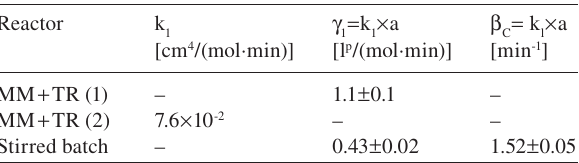
Figure 4 Parity plot in which all results of the simulation made by using different types of reactors are compared with the experi- mental results. Well stirred batch reactor ( (cid:2) ), continuous reactor fi lled with: ( (cid:3) ) stainless steel spheres of 2.5 mm diameter, ( ) double distribution of stainless steel spheres of 2.5/1 mm diameter, ( (cid:4) ) double distribution of stainless steel spheres of 2.5/0.39 mm diameter, ( (cid:5) ) stainless steel wool, ( ) threaded roads, ( ) micro- mixer in series with a void tube of 1.27 cm external diameter and 10 or 20 cm length, ( ) micro-mixer in series with a Tefl on capillary tube of 0.159 cm external diameter and 10 cm length. Runs taken from [9, 10, 19]